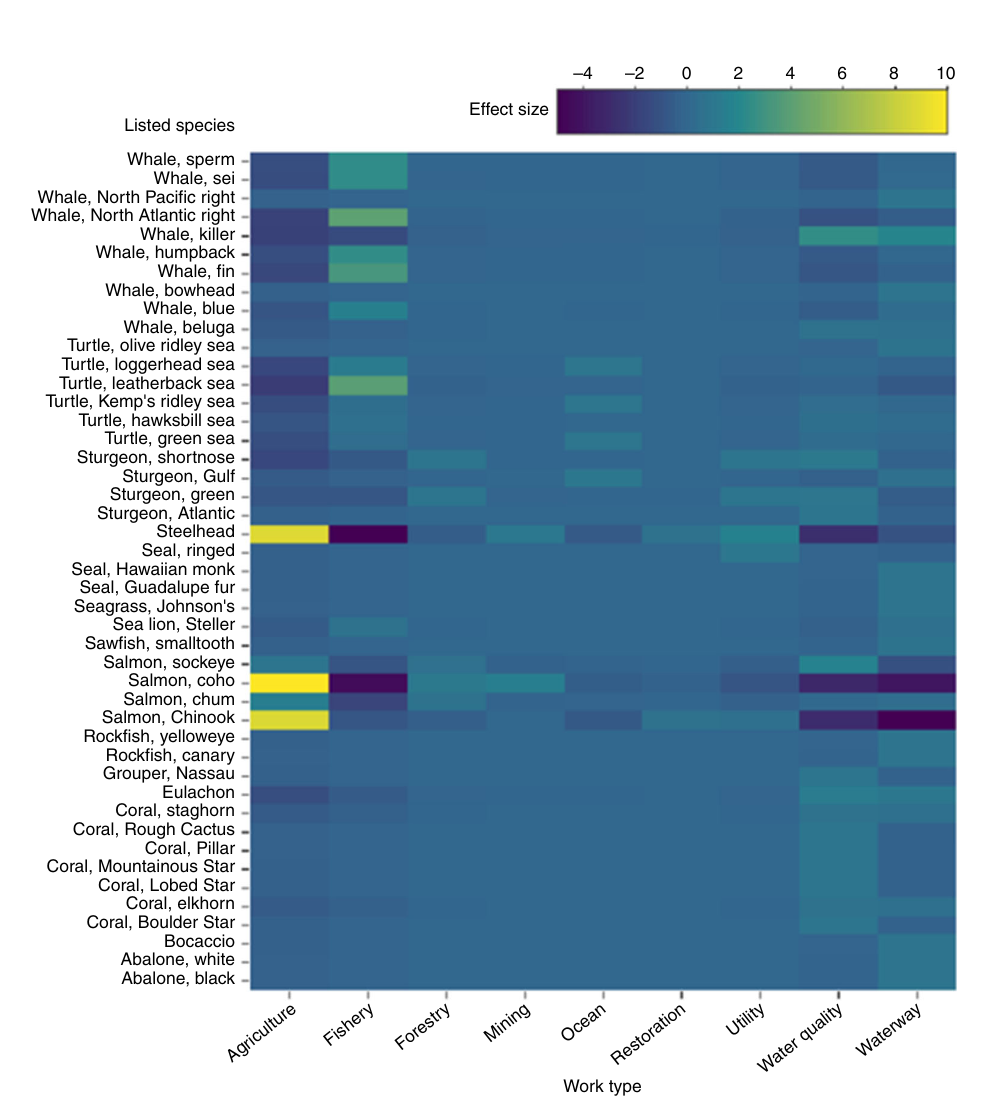
Fig. 3 Heatmap displaying differences between the observed and expected frequency of jeopardy determinations for combinations of species and work types during U.S. Endangered Species Act section 7 consultation between U.S federal agencies and the National Marine Fisheries Service from 2000 to 2017. Higher values indicate combinations for which jeopardy determinations occurred more frequently than would be expected under a random